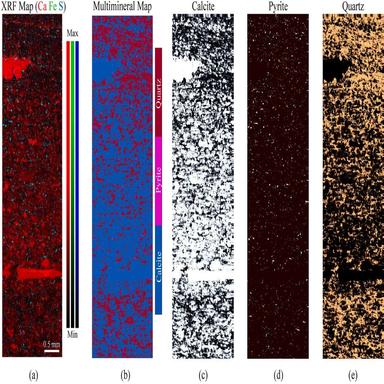
Eagle Ford shale (a) three-element XRF map of the EFS2 area (14 mm2 ) indicating calcium, iron and sulfur intensities; (b) a multimineral map of the three primary minerals, calcite, pyrite and quartz, with a 4 μm resolution, and; (c–e) single mineral maps for each mineral where black represents no presence in all three maps.